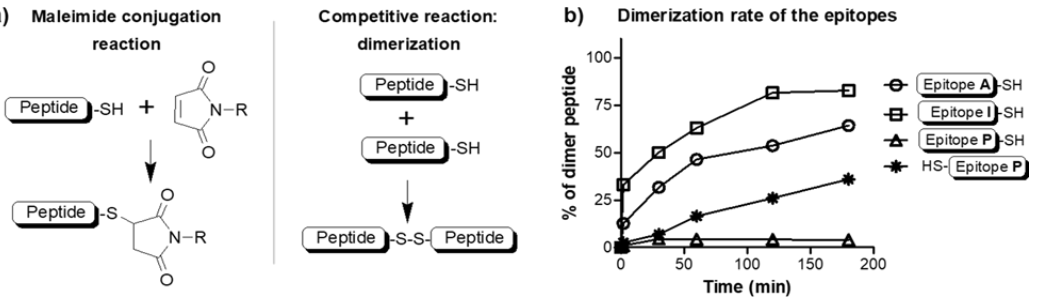
Table 1. Analytical characteristics of the peptides and peptide